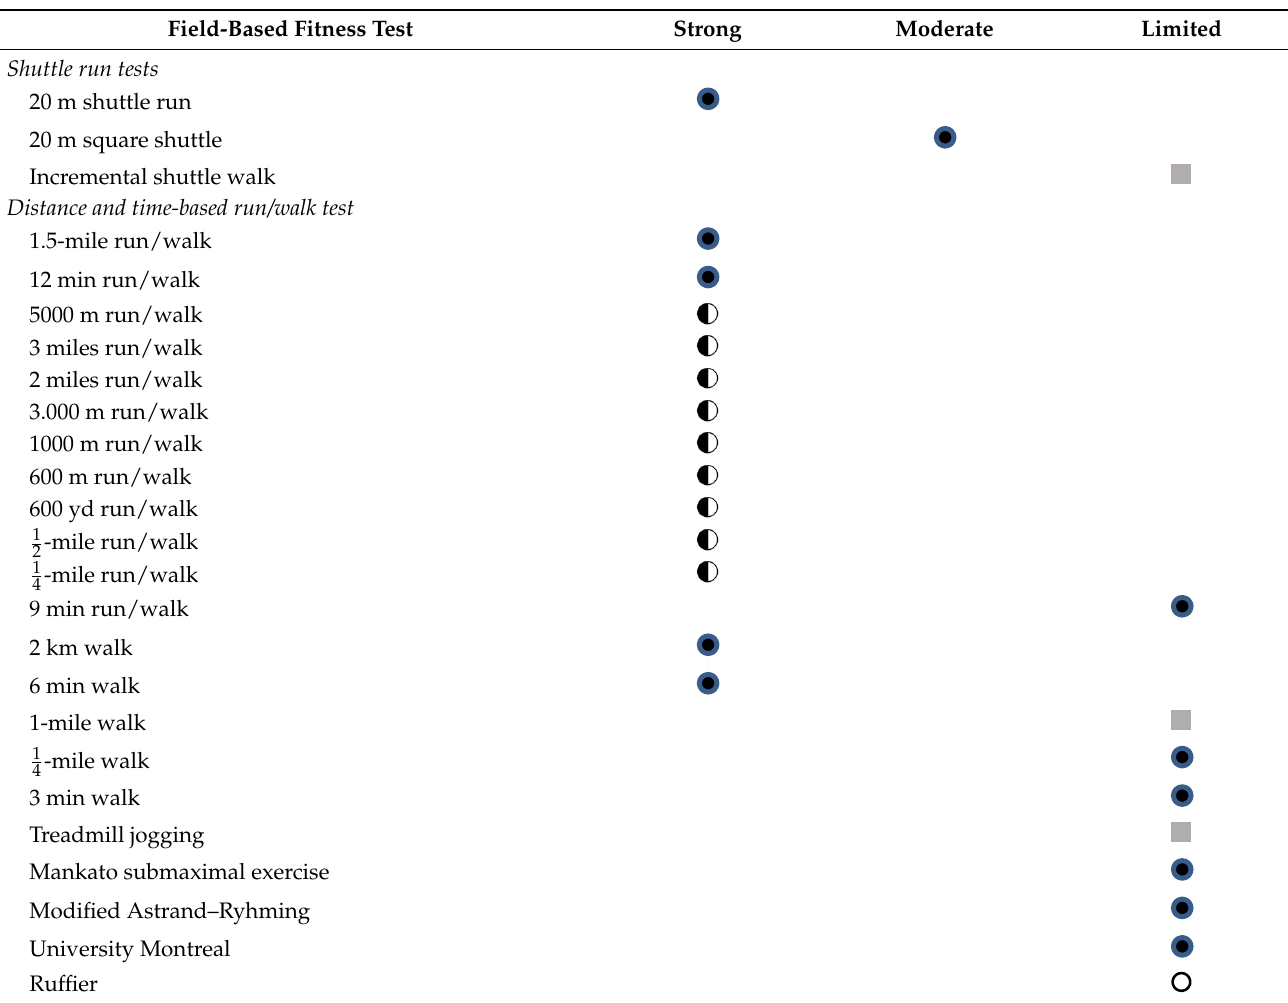
Table 1. Levels of evidence of cardiorespiratory fitness tests.